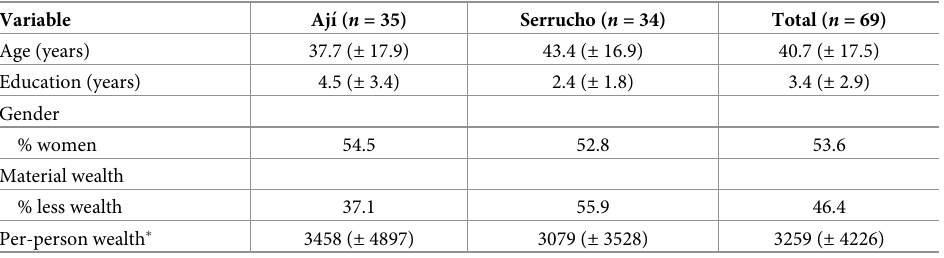
Table 2. Descriptive statistics for ratings samples from Ajı´and